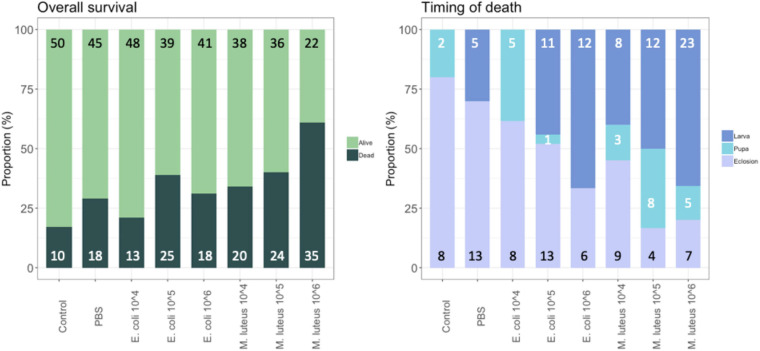
Proportion of individuals surviving and dying per treatment, with the total number per class added in the graph (left). For the individuals that died, timing of death was classified as either occurring during infection (death in the larval stage), during diapause (death as a pupae), or during eclosion (right). Graph shows the proportion of each of these groups per treatment, with the total numbers given in the graph.